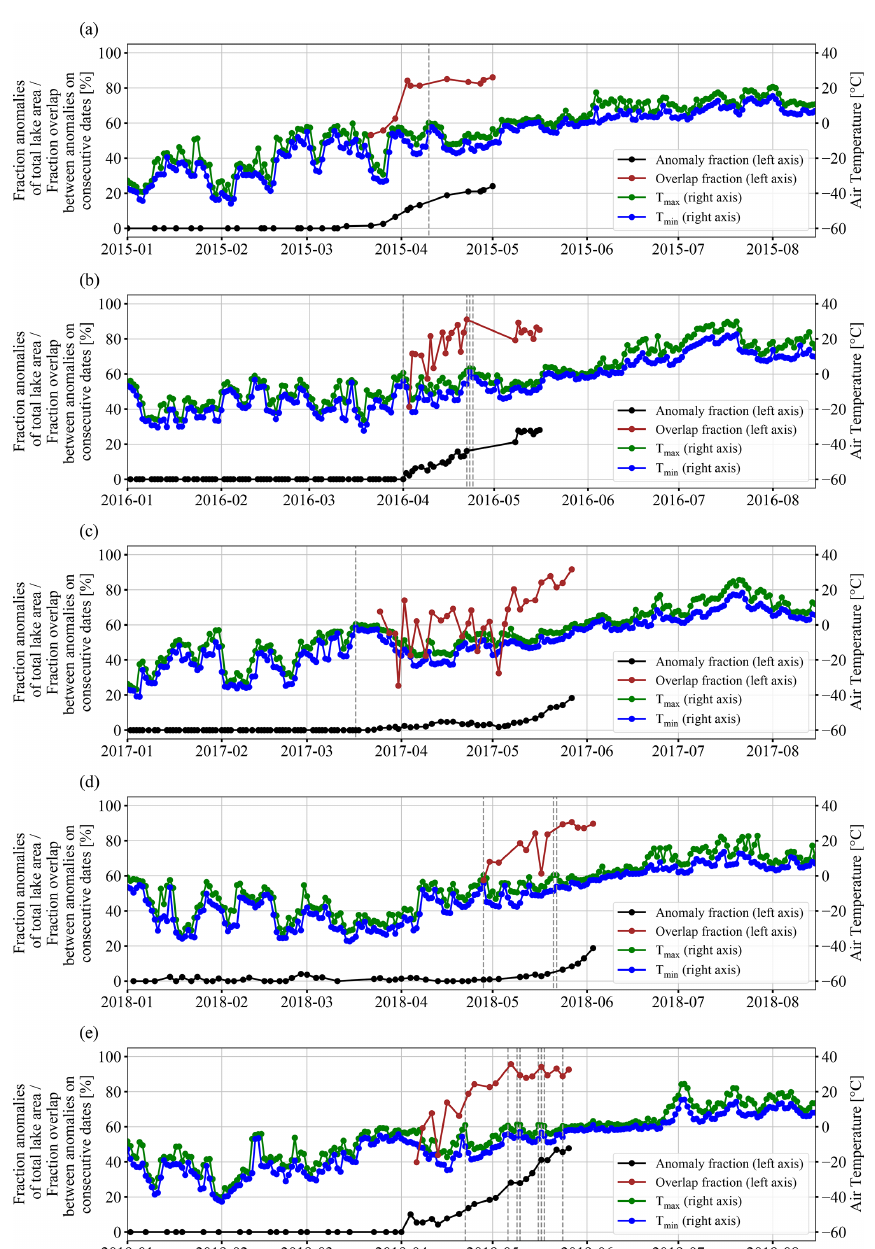
Figure 10. Time series of fraction of area of anomaly regions with respect to total lake area (black; Pointner and Bartsch, 2020), fraction of overlap between anomaly regions on consecutive dates (brown) for the time period after no anomalies were detected for the last time in the years concerned, and maximum (green) and minimum (blue) 2m air temperature from ERA5 (Hersbach et al., 2018). The left axis indicates the fraction of area of anomaly regions with respect to total lake area and the fraction of overlap between anomaly regions on consecutive dates. The right axis indicates air temperature. Fractions of overlap were calculated as the area of intersection between classified anomaly regions on the timestamp indicated and that of the previous timestamp, divided by area of the classified anomaly regions at the previous timestamp. Dashed grey lines indicate dates where maximum air temperature exceeded 0 ◦ C during the analysis periods of the SAR